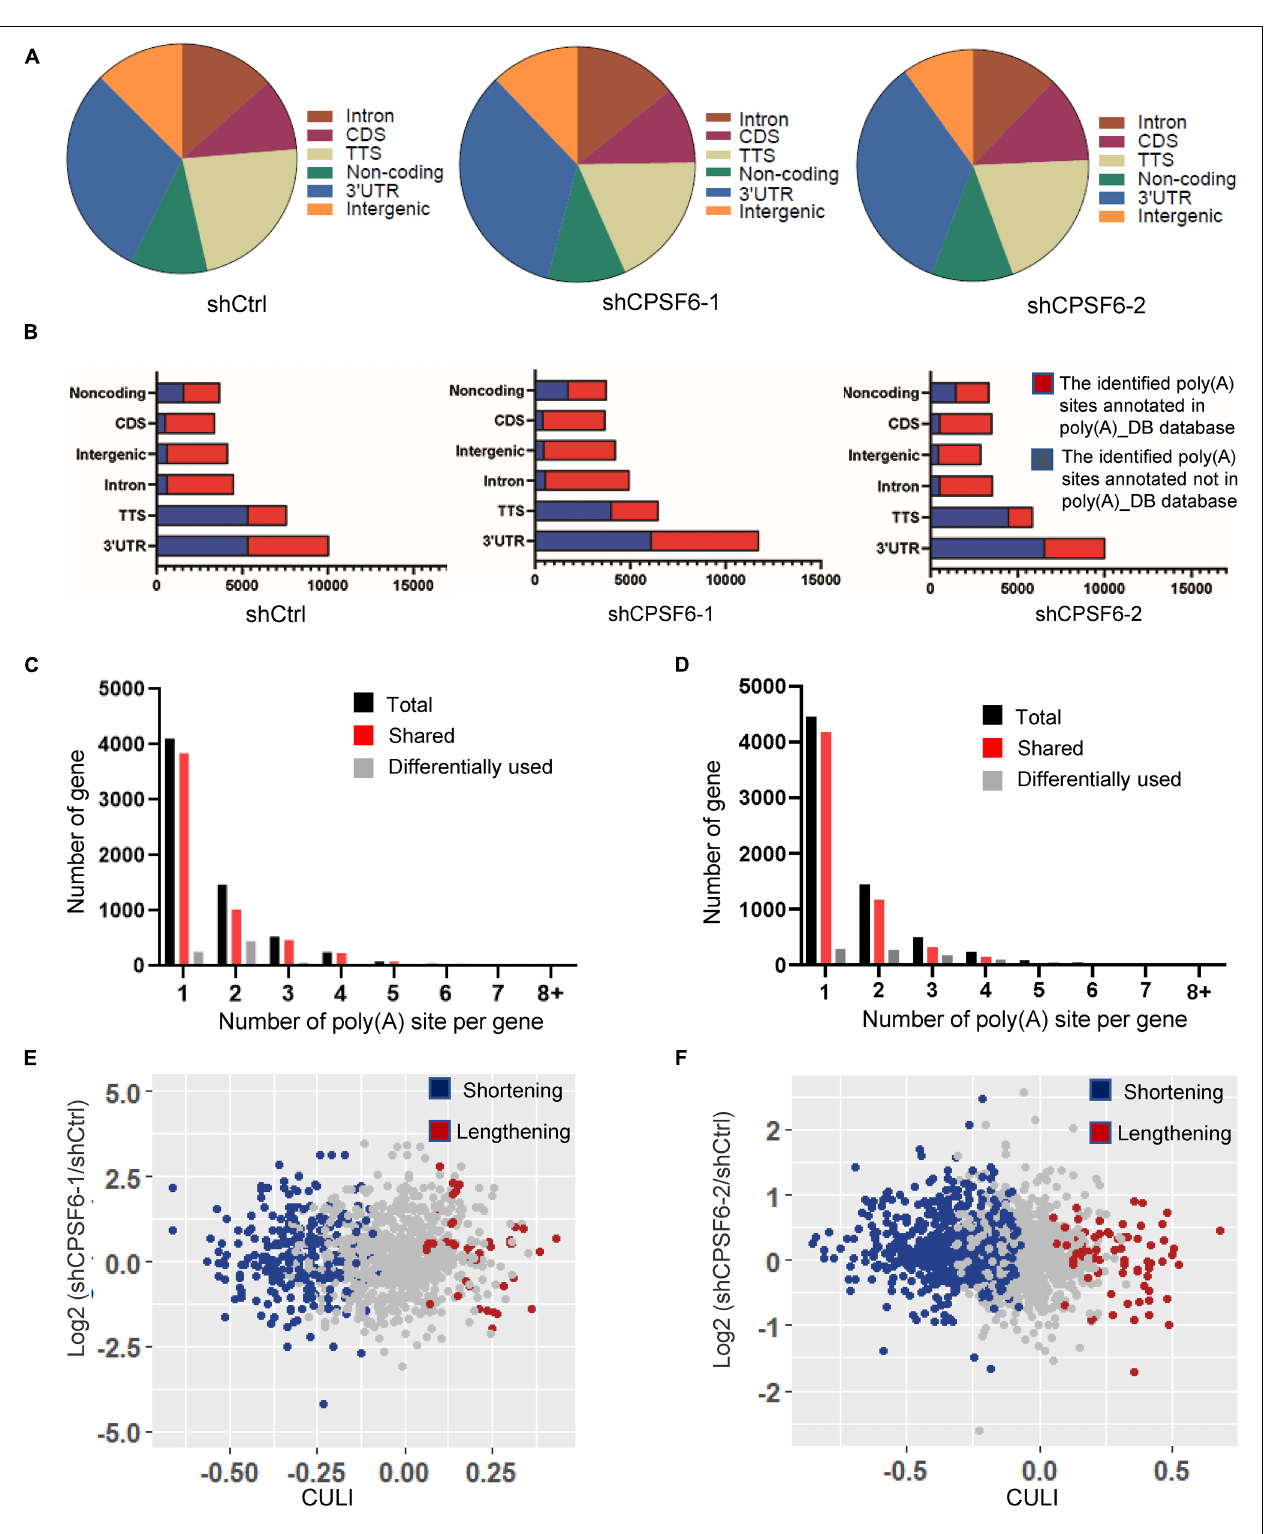
FIGURE 4 | Characteristics of 3T-seq data. (A) Genomic locations of 3T-seq reads mapped to the reference genome after filtering internal priming events. (B) Genomic distribution of the poly(A) sites. (C,D) The statistics of genes with various number of detected poly(A) sites in different libraries. (E,F) Scatterplot of CULI in CPSF6 knockdown and control cells [false discovery rate (FDR) < 0.05] in different libraries.